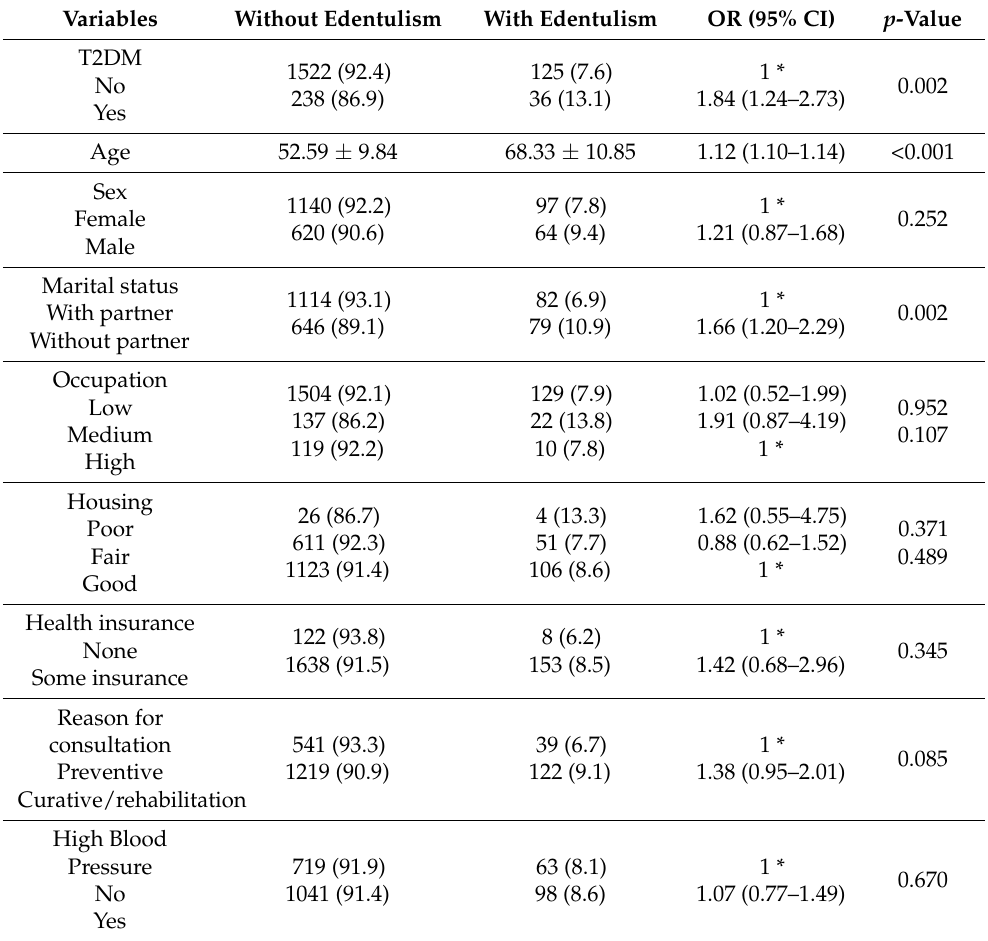
Table 2. Bivariate analyses of the prevalence of edentulism across the independent variables included in the study.